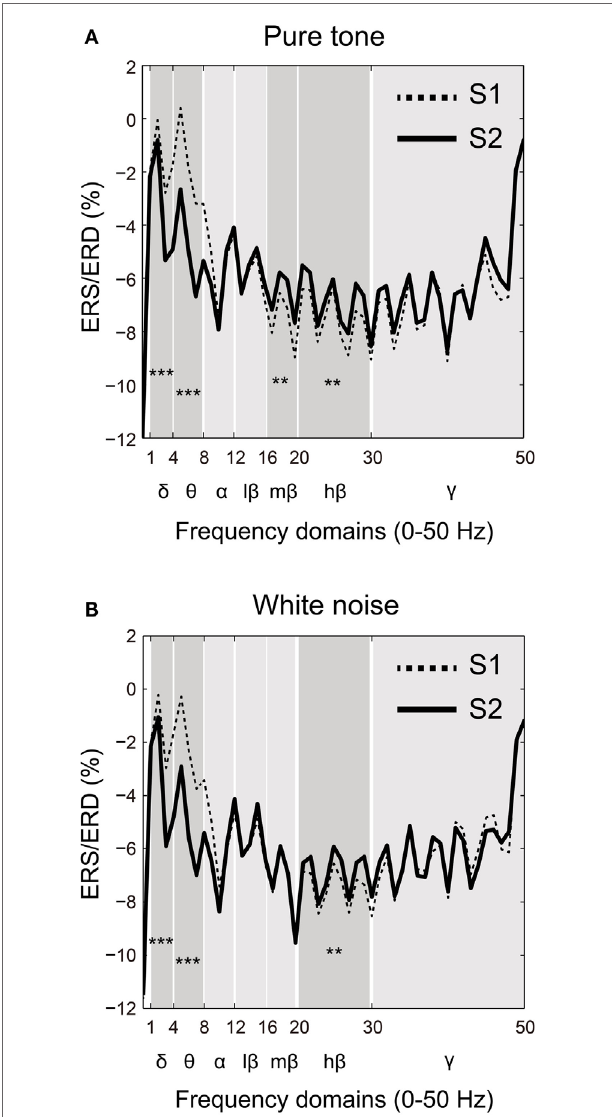
FigUre 4 | Frequency-domain analyses of the first (s1: broken line) and second (s2: solid line) stimuli compared for (a) pure tone and (B) white noise . Power changes of major frequency bands ( δ : 1–4 Hz; θ : 4–8 Hz; α : 8–12 Hz; β : 12–30 Hz; and γ : > 30 Hz) were represented by event-related synchronization or desynchronization (ERS/ERD). A β band was also separated into low (12–16 Hz), middle (16–20 Hz), and high (20–30 Hz) ranges. For both pure tone and white noise, δ and θ bands for S2 showed greater (more negative) ERD than those for S1, and a high β band for S2 conversely showed smaller (more positive) ERD than for S1. Unlike white noise, pure tone yielded smaller ERD of a middle β band for S2 than for